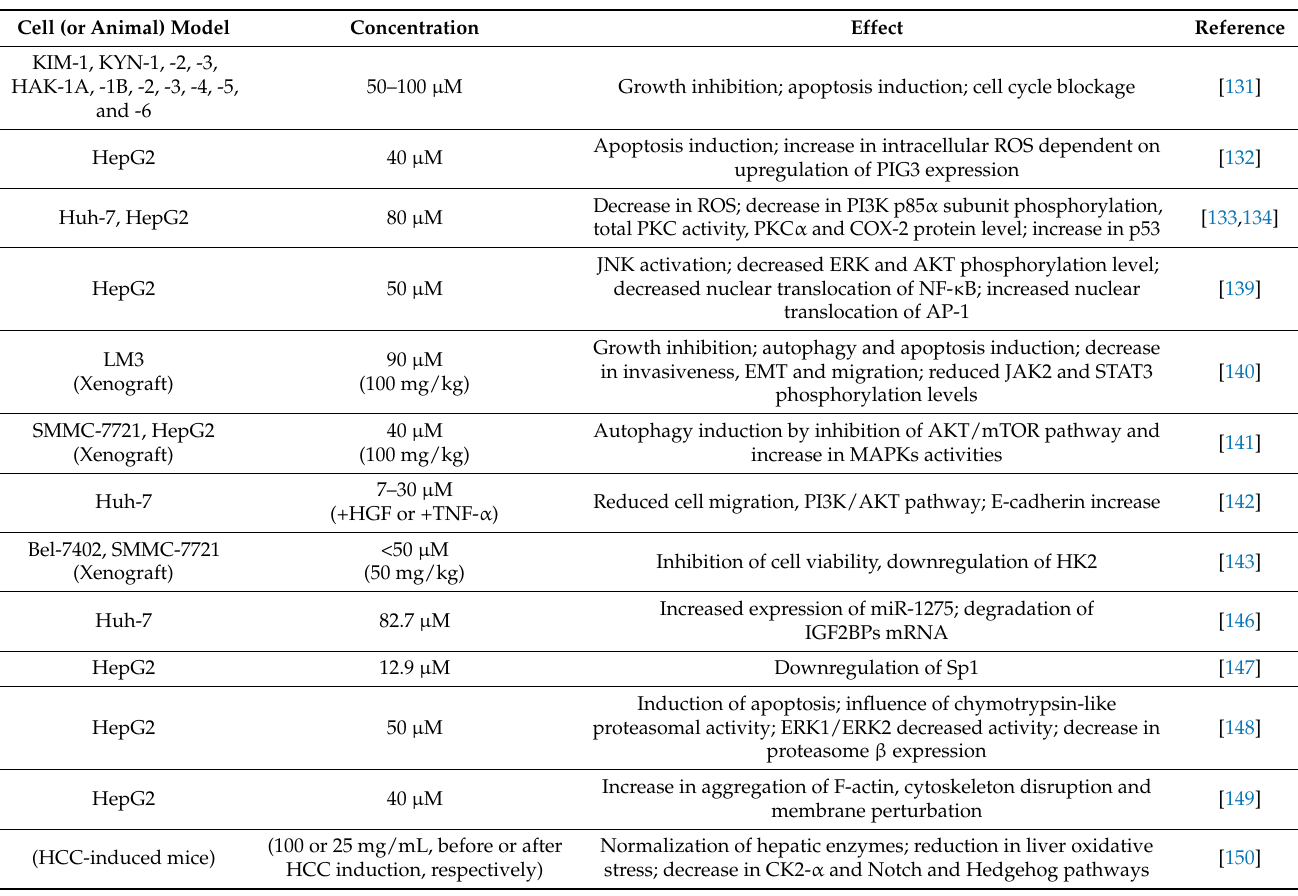
Table 7. Targets affected by quercetin free form in HCC experimental